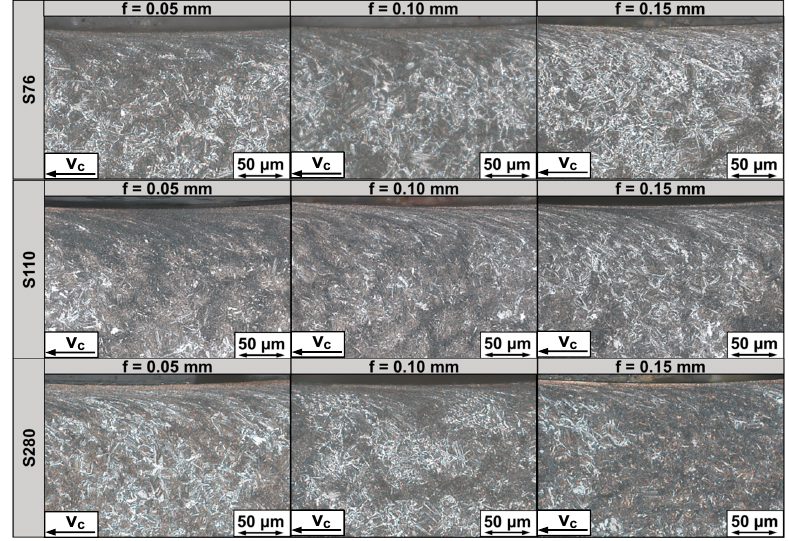
Figure 6. Microstructure of specimens made of S76, S110 and S280 and feed rates 0.05 mm, 0.10 mm and 0.15 mm.